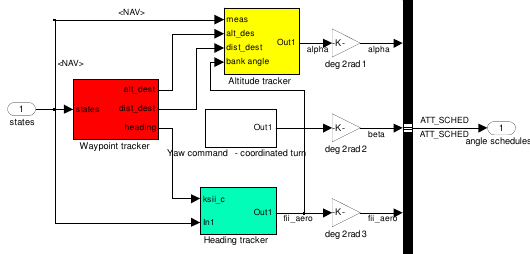
Fig 3. Guidance law implemented in a Simulink model. The output of the law are aerodynamic angles that are fed to the kinematic conversion block in the point mass synthetic environment to produce conversion matrices T and T BW VW